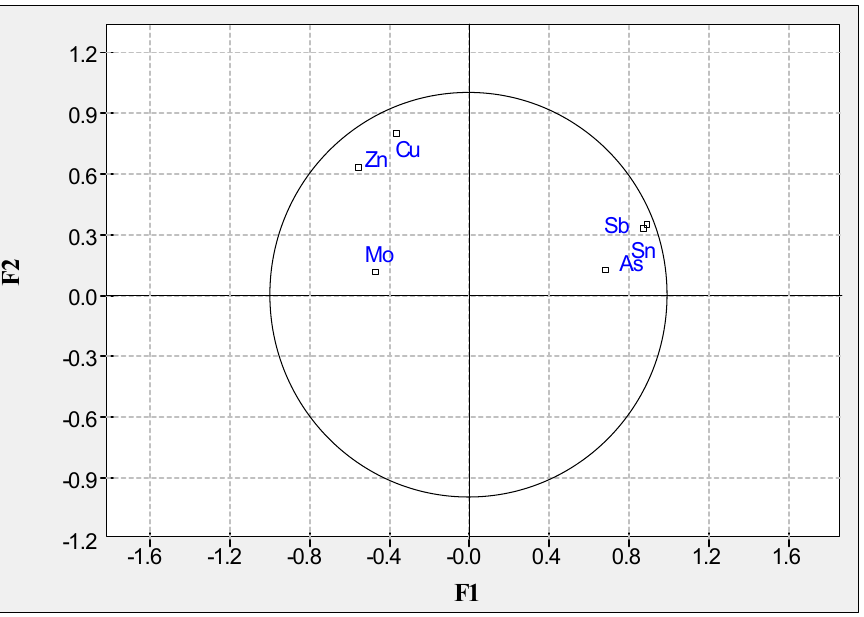
Figure 9. Principal components analysis, projection of variables in the first factorial plan F1, F2 (software ANDAD, vs 7.12, CVRM/IST 2000, Lisbon, Portugal).